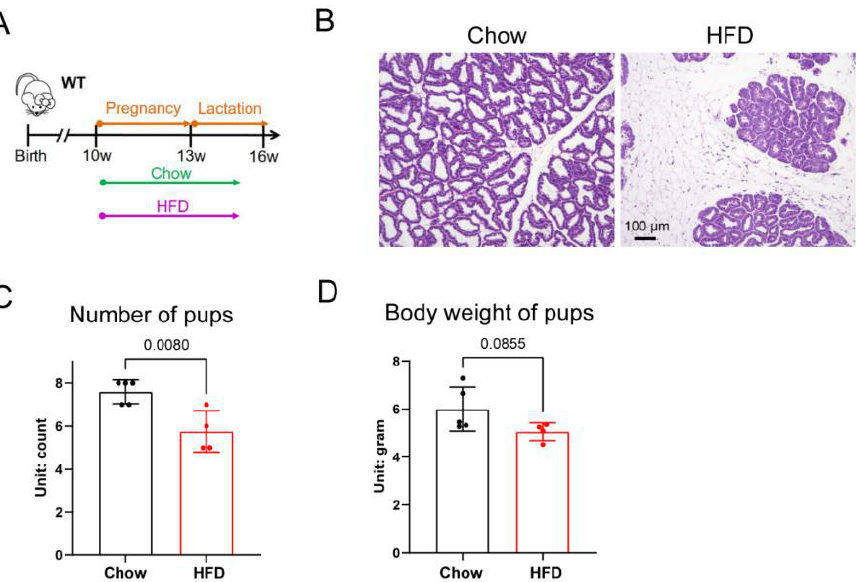
Figure 1. Obese female mice have impaired adipocyte remodeling and difficulty in supporting neonate growth. ( A ) Experimental treatment scheme to study how HFD feeding affects adipose tissue remodeling during lactation and the consequences for the pups. ( B ) H&E staining of mammary tissue from chow- or HFD-fed mice after lactating pups for 9 days. ( C ) Number of pups produced by dams under chow-fed or HFD conditions ( n = 5 for chow group, n = 4 for HFD group). ( D ) Average body weight of pups nurtured by dams kept on chow or HFD (the average body weight of pups from one dam is regarded as one sample. n = 5 for chow group, n = 4 for HFD group). All data are mean ± SEM.